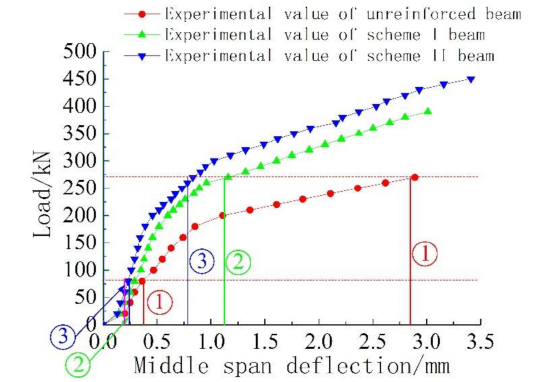
Figure 16. The experimental value of mid-span deflection under three working conditions. Note: 1 (cid:13) 2 (cid:13) 3 (cid:13) represent Unreinforced beam, Scheme I beam and Scheme II beam,